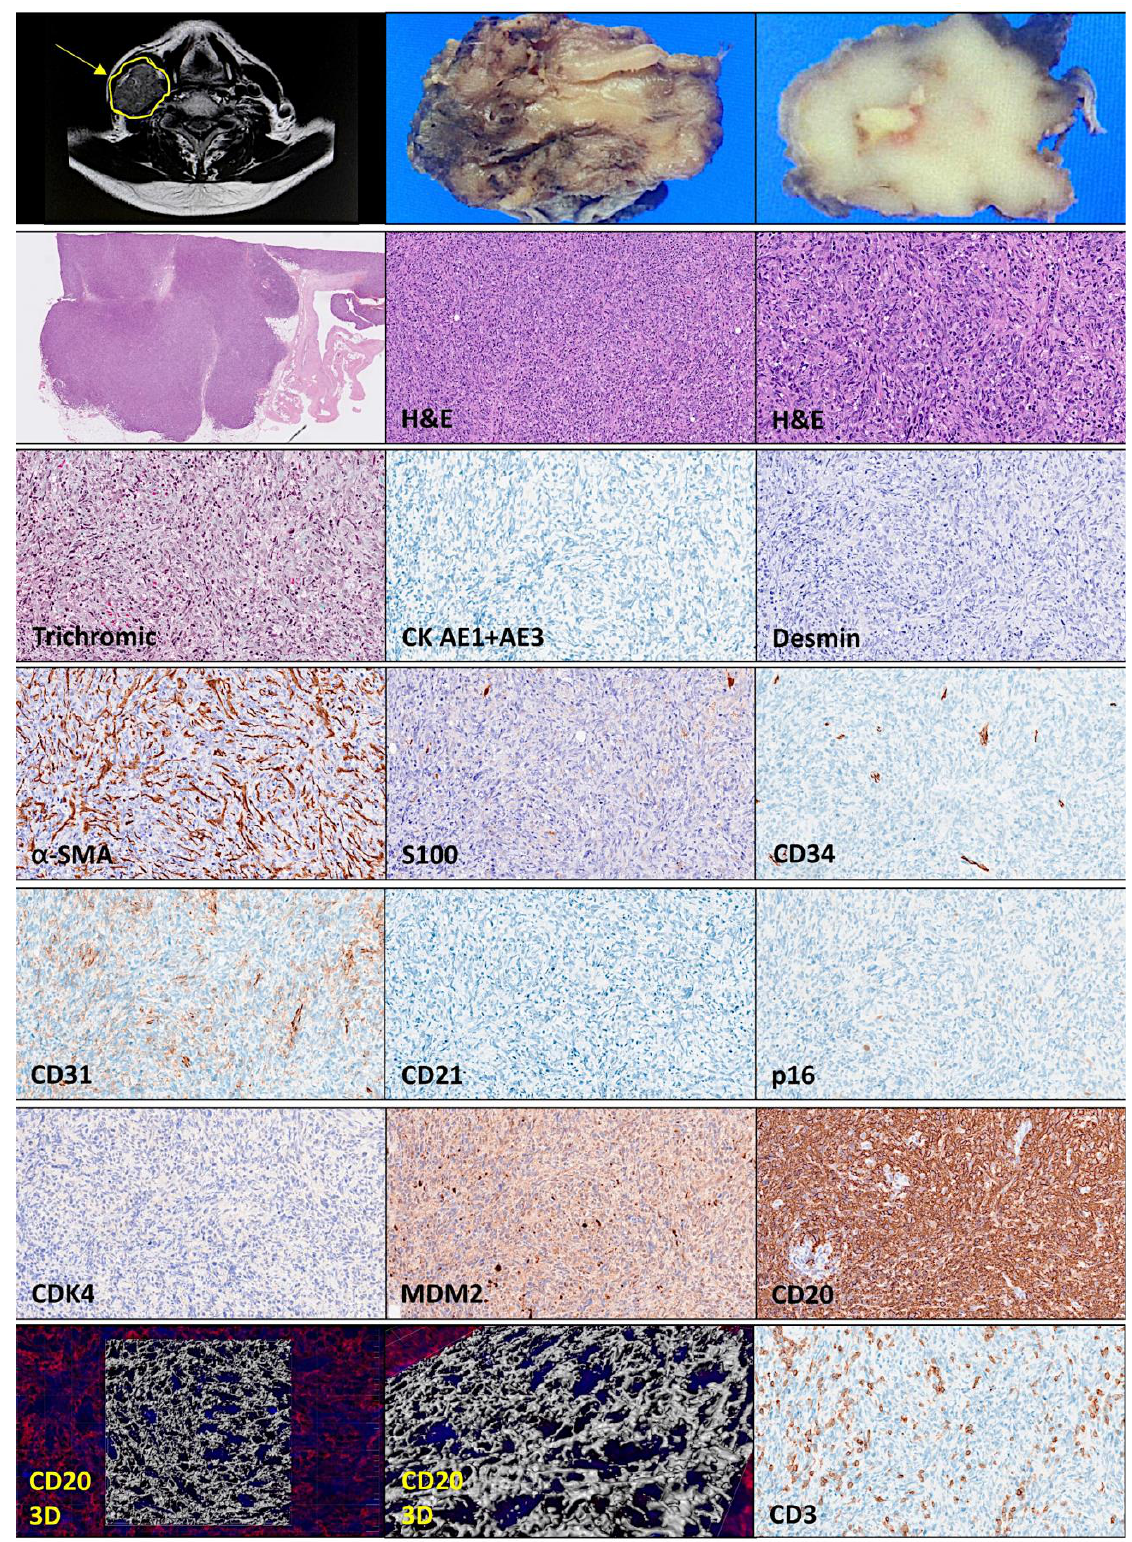
Figure 1. Histological features of the right supraclavicular (lymph) node enlargement. The histolog- ical features showed a diffuse proliferation of spindle cell cells that were MDM2- and CD20-positive. The spindle cell morphology was confirmed using confocal microscopy and 3D rendering.